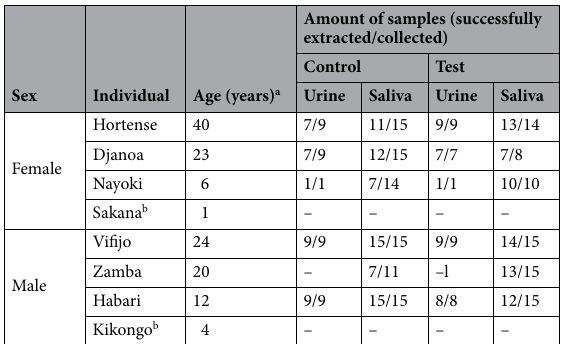
Table 1. Subject information. a Age: individual’s age when the study took place. b Did not provide any samples in this